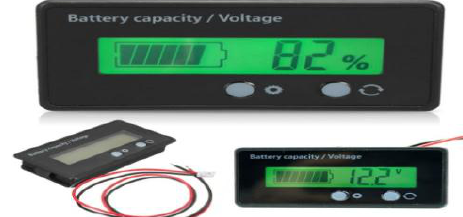
Fig. 9. Battery Percentage